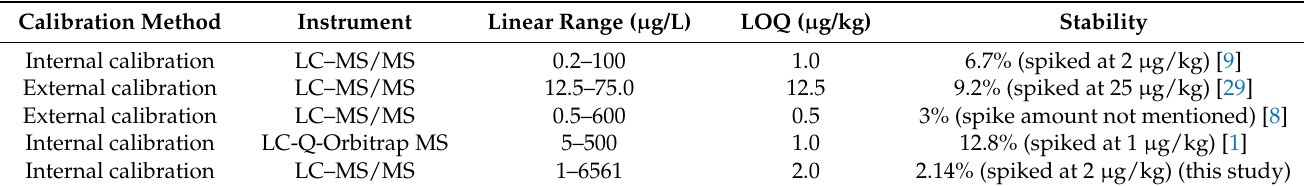
Table 3. Comparison of the developed method with previous reports of ENR residue tests using mass